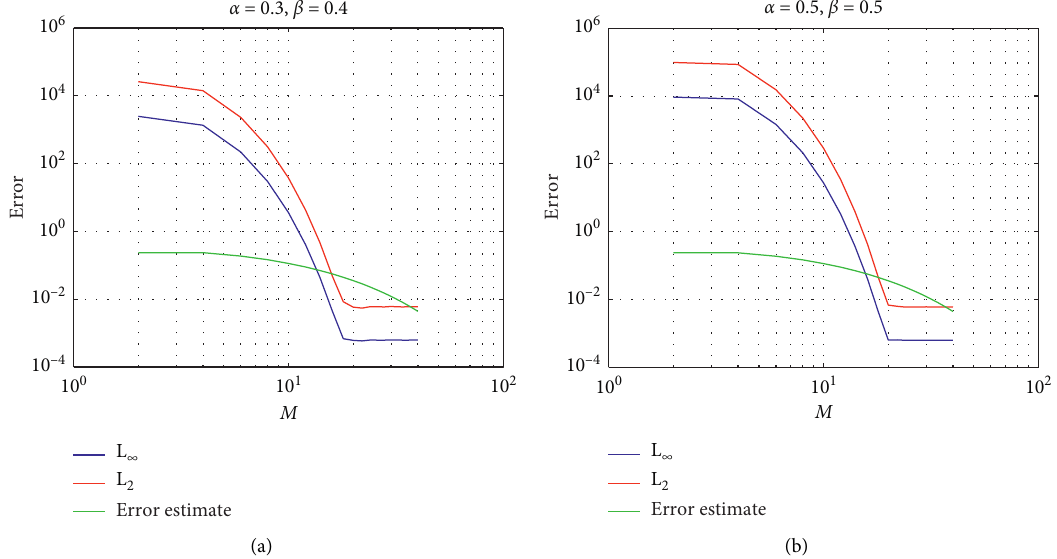
Figure 3: Error versus quadrature points M at N � 20, n � 11, and t � 1 and various values of α , β corresponding to Problem